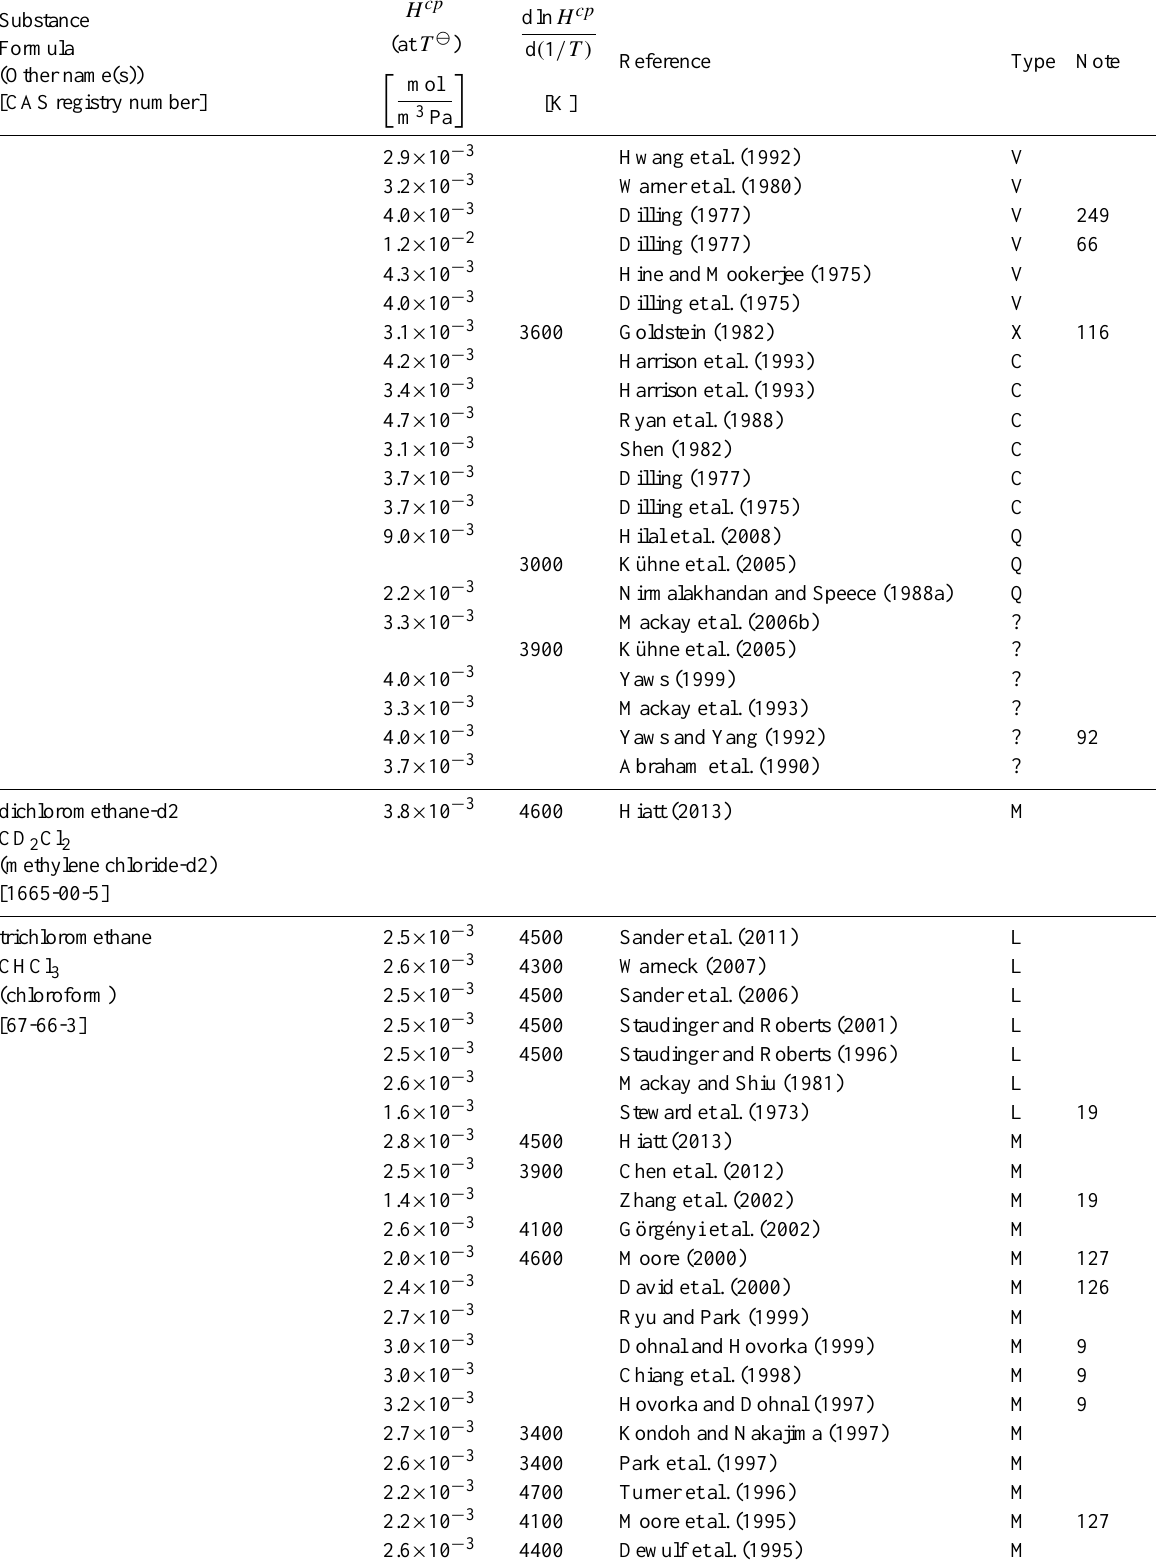
Table 6: Henry’s law constants for water as solvent